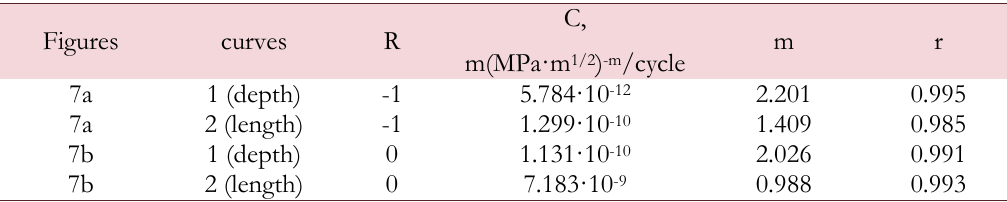
Table 2: Coefficients C and m of Eq. (1) and correlation coefficients r for the curves shown in Fig. 7.